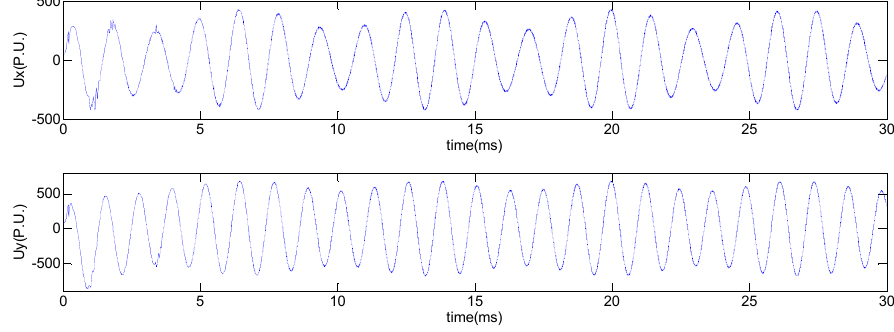
Figure 16. Control forces in the X and Y direction.